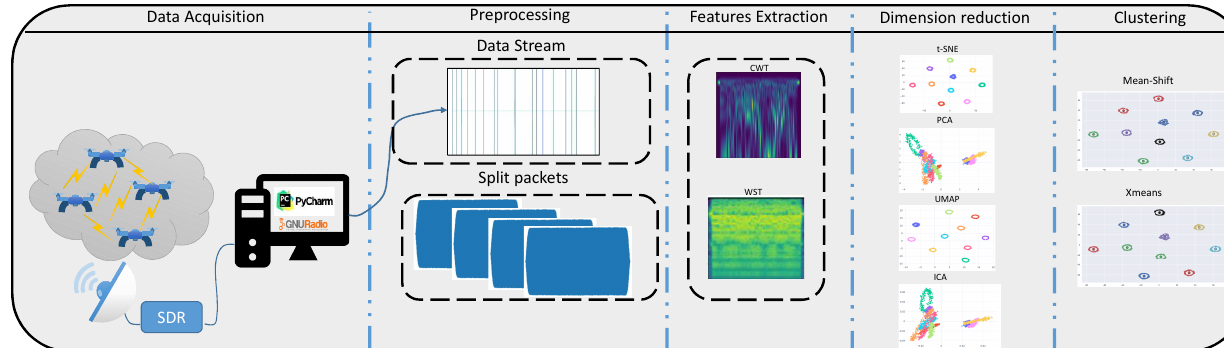
Figure 1. Proposed method